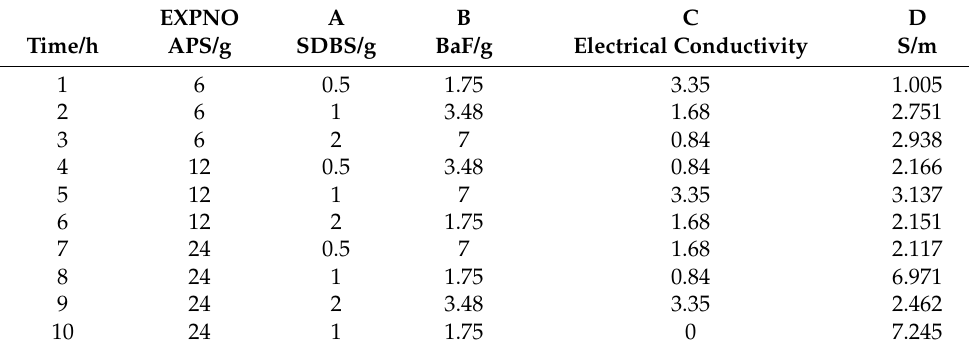
Table 3. Electrical properties of the